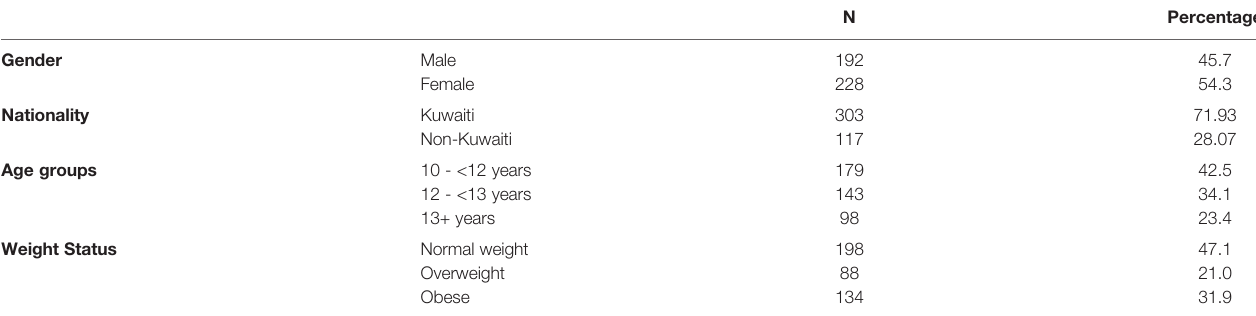
TABLE 1 | Characteristics of the study